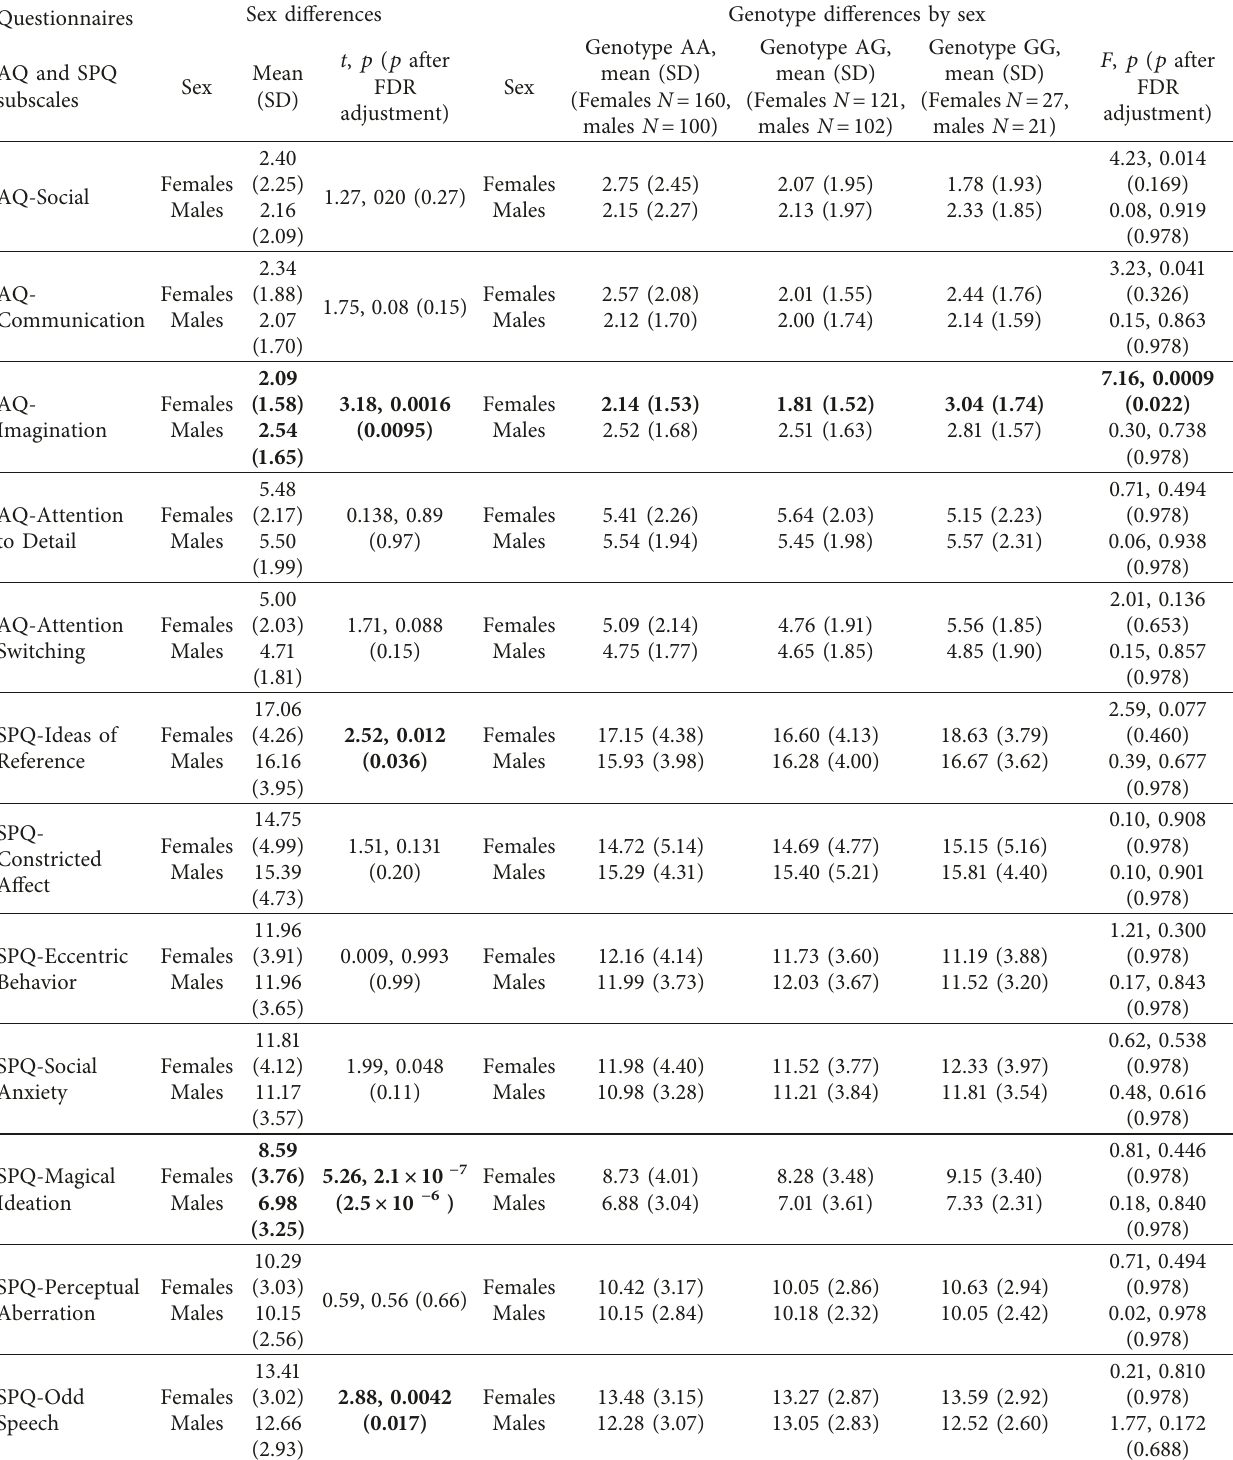
Table 1: Sex and genotype variation for the Autism Quotient and Schizotypal Personality Questionnaire subscales, for the AMBRA1 SNP